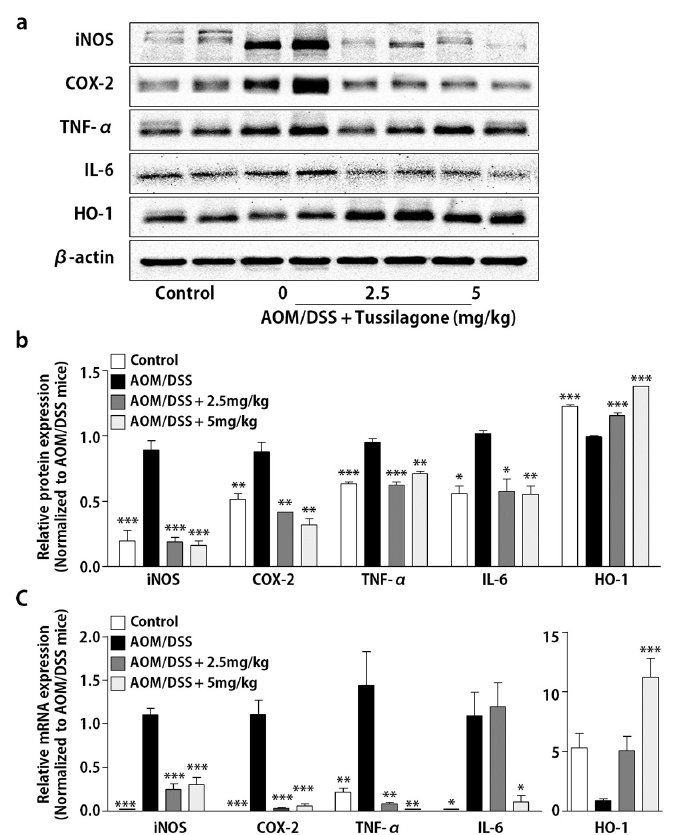
Figure 2. Treatment with tussilagone inhibited AOM/DSS-induced inflammatory mediators in the colon. ( a ) iNOS, COX-2, TNF- α , IL-6 and HO-1 in the colons of mice were detected by Western blot and visualized by chemiluminescence. Representative results are shown and β -actin served as an equal loading control. ( b ) The inflammatory mediator proteins were quantified by densitometric analysis and normalized to β -actin. ( c ) The colonic levels of iNOS, COX-2, TNF- α , IL-6 and HO-1 mRNAs were quantified by real-time RT-PCR and normalized with respect to the mRNA level of the housekeeping gene, GAPDH. Results are expressed as the mean ± SEM. * P < 0.05, ** P < 0.01, *** P < 0.001, compared to the AOM/DSS-treated mice.